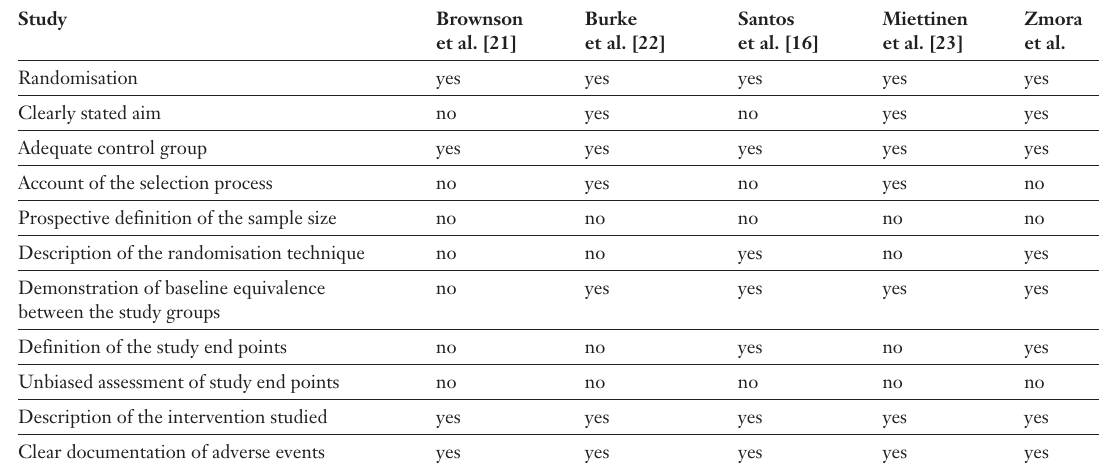
Table 2 Assessment of the randomised